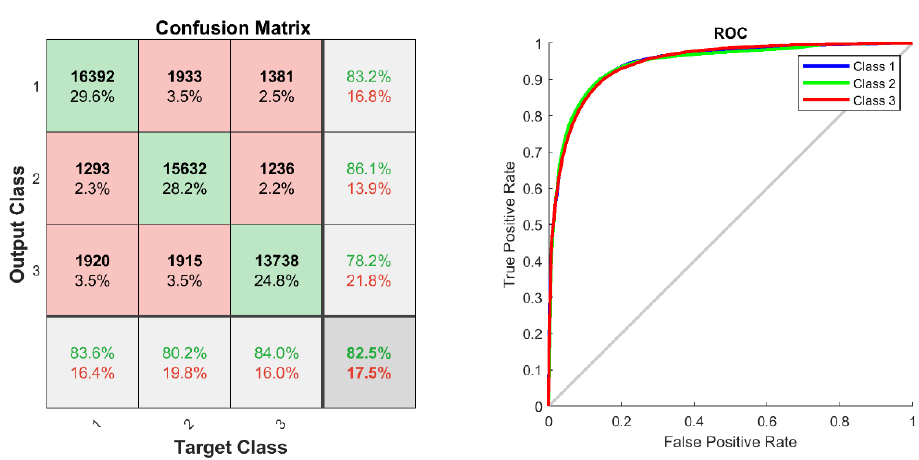
Figure 8. Confusion matrix ( left ) and ROC curve ( right ) of classifier for subject 1 on test data.